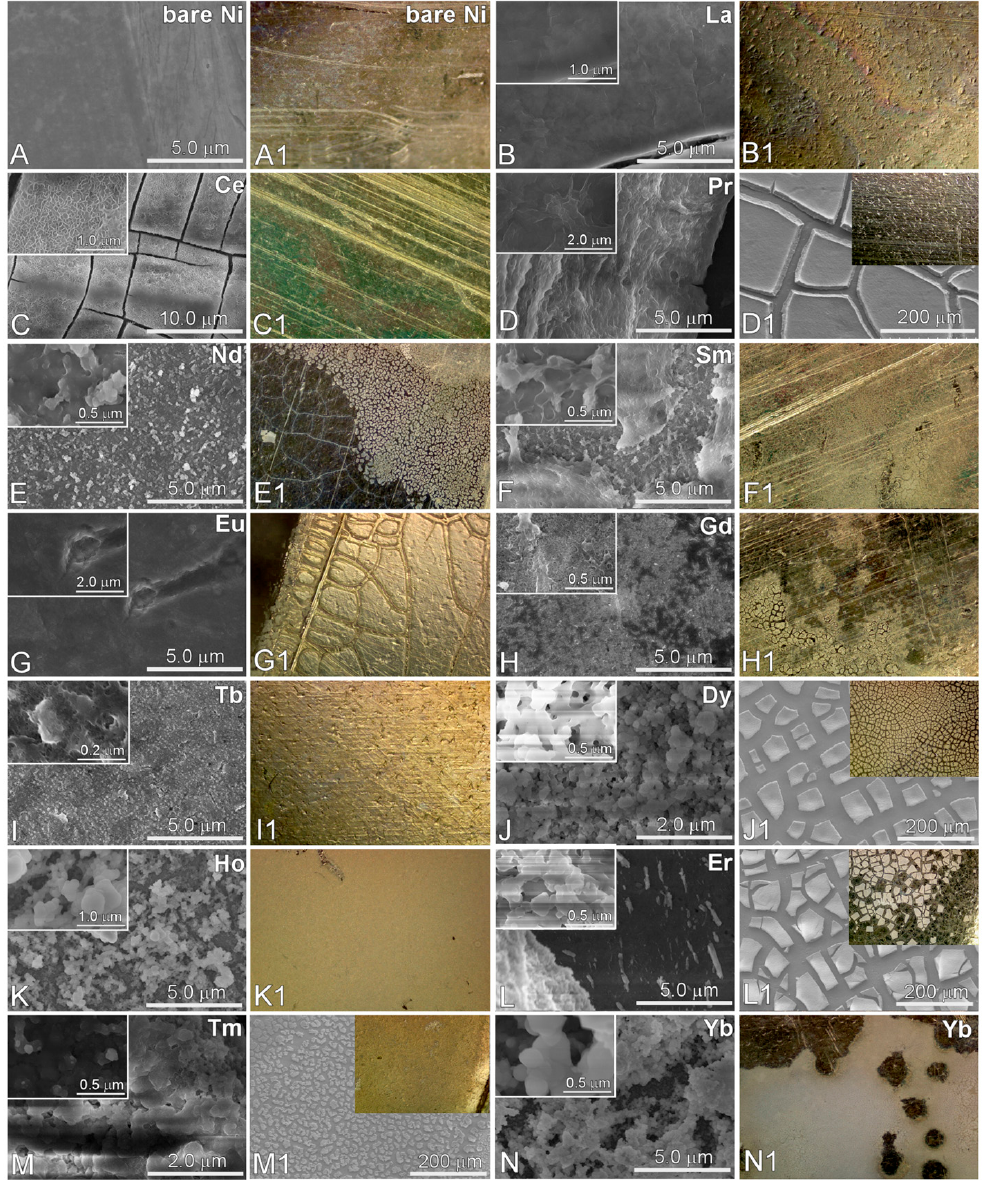
Figure 2. SEM images ( A – N ) and optical microscope (300 × ) images ( A1 – N1 ) are shown for a bare Ni sheet ( A ) and electrodeposited RE elements on a Ni sheet (from B – N ).